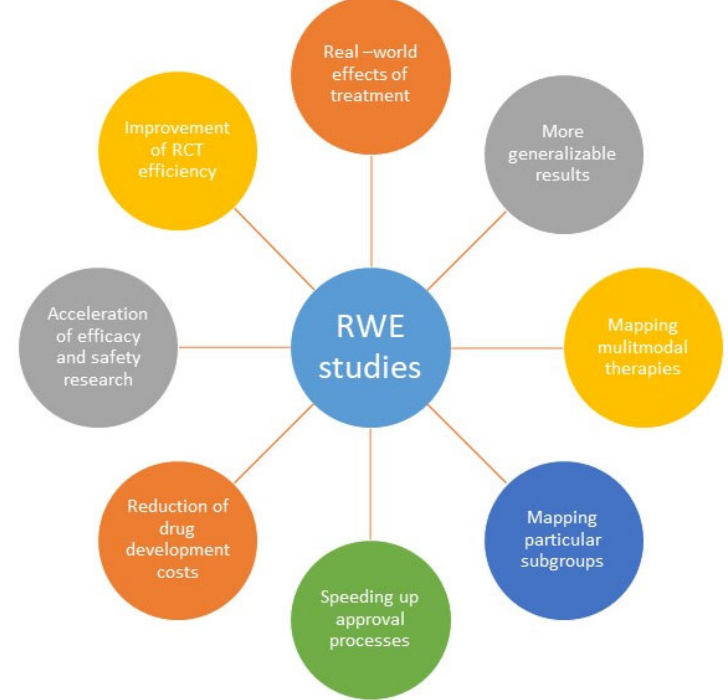
Figure 3. Potentials of RWE studies.